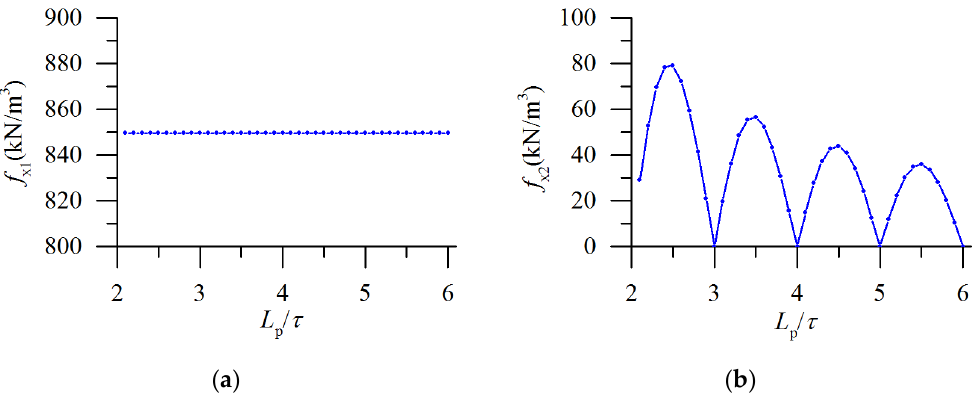
Figure 9. The curves of the two ‐ eddy current braking force density along with the change of L p / τ . ( a ) The curve of f x1 along with the change of L p / τ ; ( b ) The curve of f x2 along with the change of L p / τ .